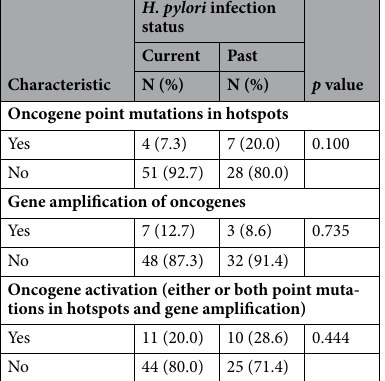
Table 3. Molecular profiles in 90 gastric